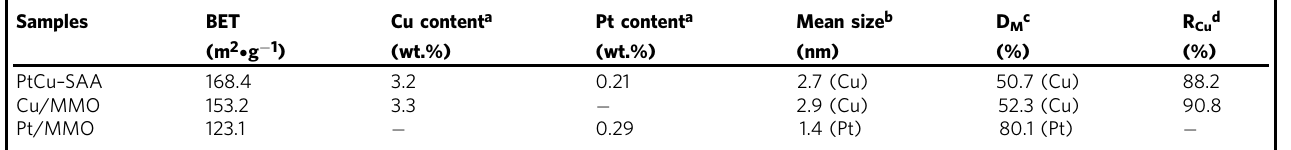
Table 1 Physicochemical parameters of